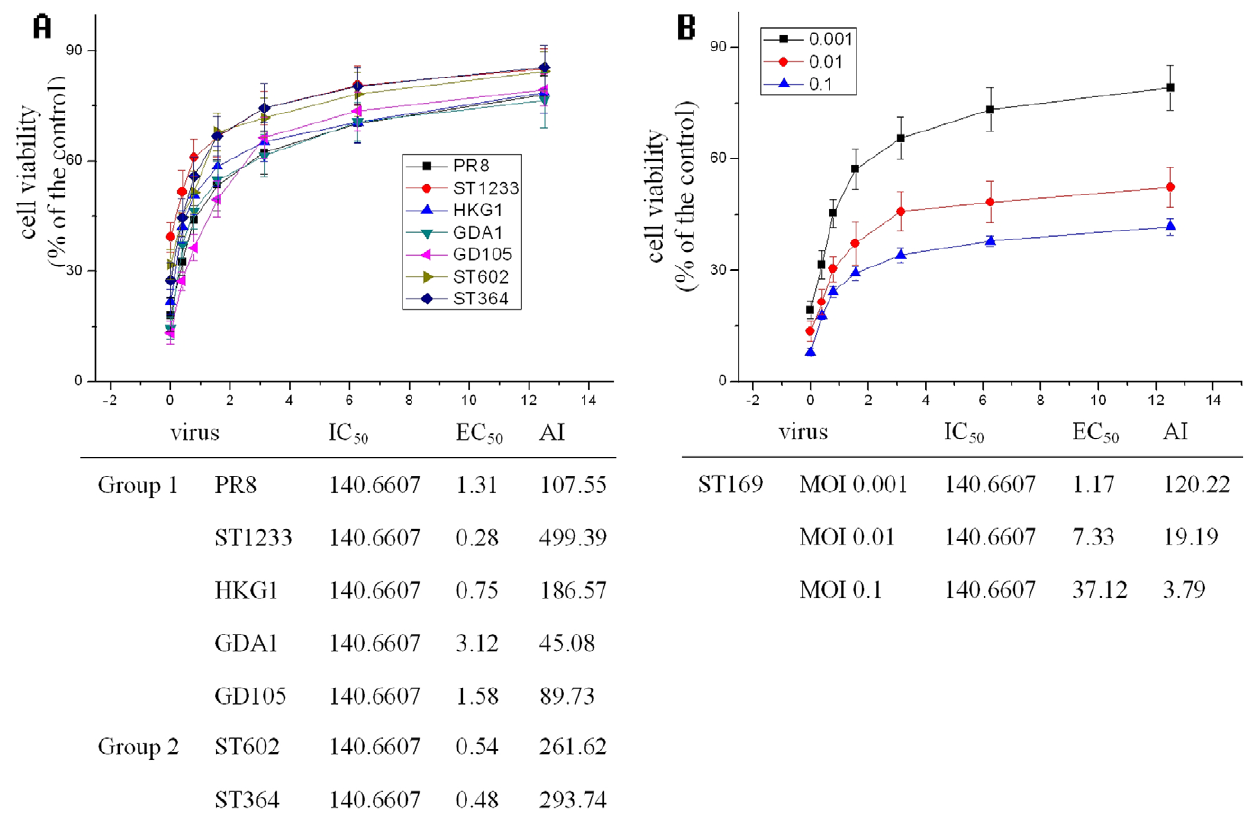
Figure 4. Evodiamine inhibits the replications of several IAV strains. ( A ) The antiviral activity of evodiamine on 7 IAV strains including A/ PuertoRico/8/34 (H1N1, PR8), A/ShanTou/1233/06 (H1N1, ST1233), A/Quail/HongKong/G1/97 (H9N2, HKG1), A/Chicken/Guangdong/A1/03 (H9N2, GDA1), A/Chicken/Guangdong/1/05 (H5N1, GD105), A/ShanTou/602/06 (H3N2, ST602) and A/ShanTou/364/05 (H3N2, ST364) by Sulforhodamine B (SRB) method using CPE reduction, MOI=0.001, incubation time=48 h. ( B ) The antiviral activity of evodiamine on A/ShanTou/169/06(H1N1) at different MOI (0.001, 0.01, and 0.1) by Sulforhodamine B (SRB) method using CPE reduction, incubation time=48 h.